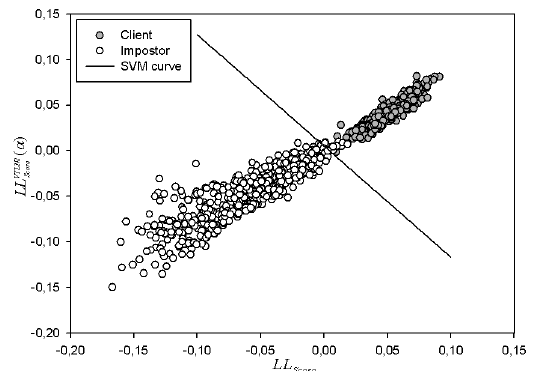
Figure 3. Discrimination between client and impostor with SVM by LL and ( ) VTLN LL ! using Score Score